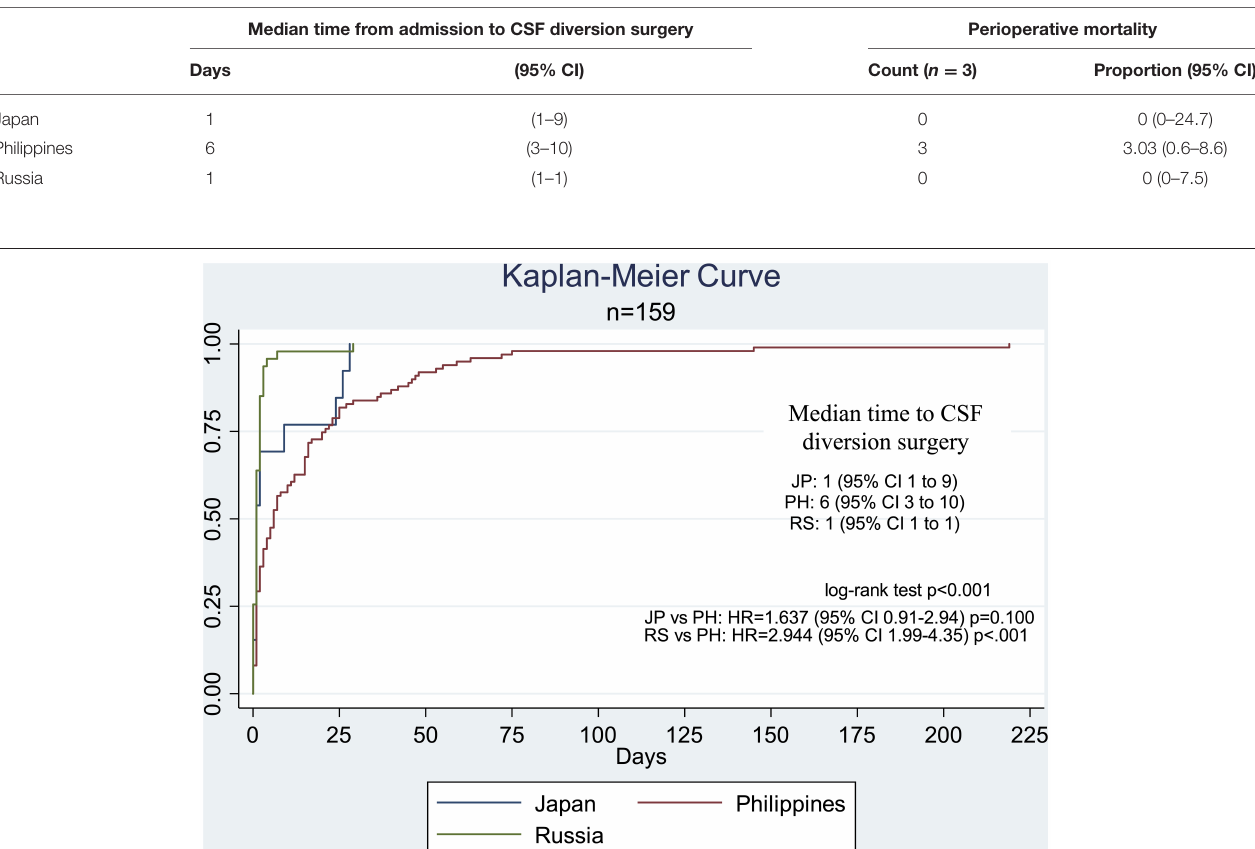
TABLE 2 | Primary outcome variables across different centers from the three countries. Median time from admission to CSF diversion surgery